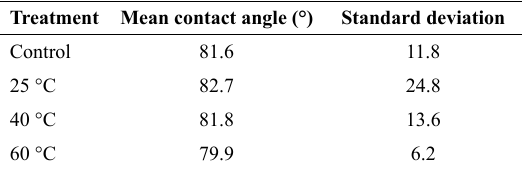
Figure 8 . Grazing-angle XRD pattern of untreated control and surfaces exposed to piranha solution for 30 min at 25 °C, 40 °C, and 60 °C. Table 2. Contact angles of Ti6Al4V control and surface-treated